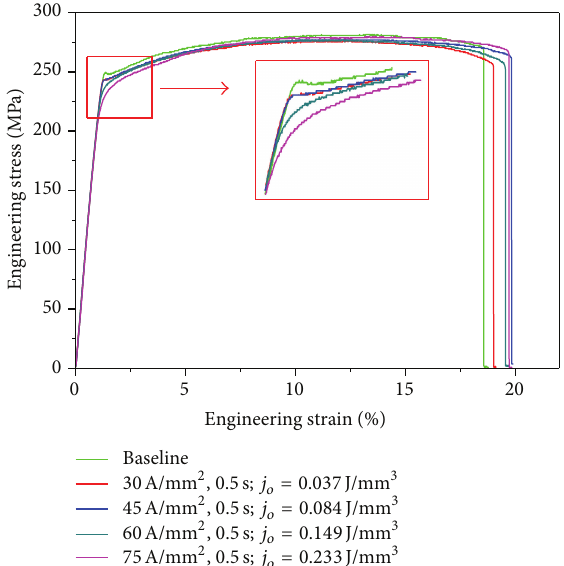
Figure 10: The stress-strain curves of the reloading tensile tests.